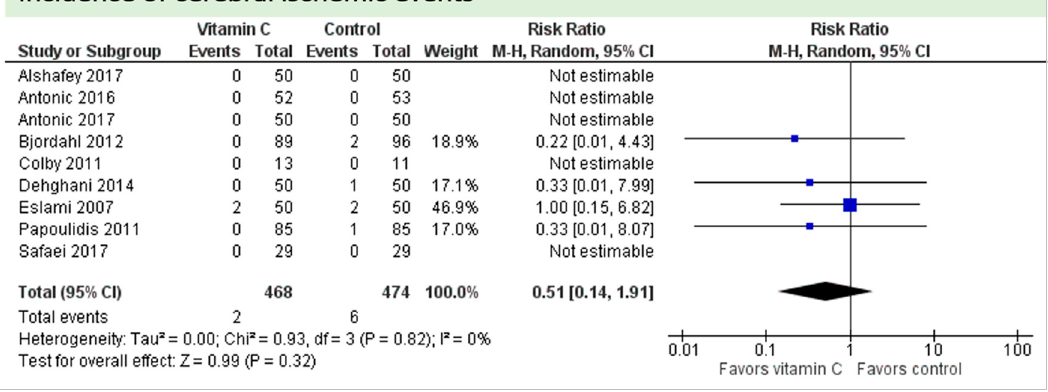
Figure 4. Total cerebral ischemic events.